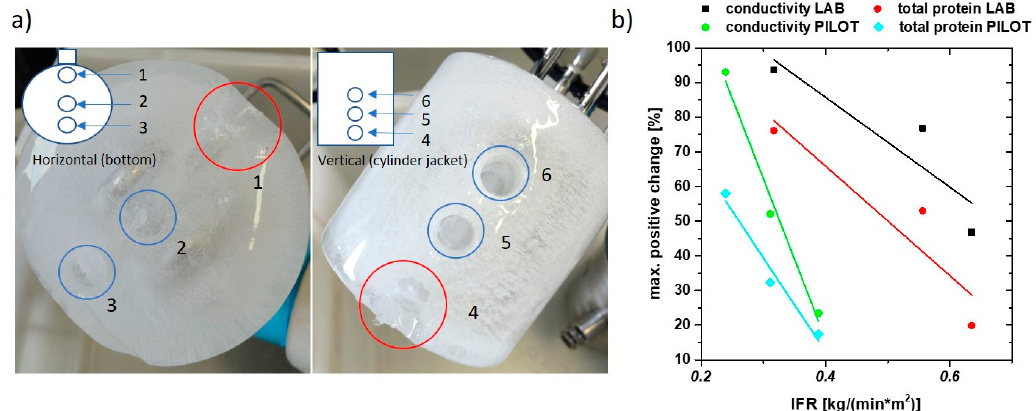
Figure 7. ( a ) Sampling scheme for tests with the pilot-scale system. Three samples were taken at the bottom of the frozen sample (horizontal) and three samples next to the jacket in different height (vertical); ( b ) conductivity and total protein concentration change in % vs. IFR. Very similar dependence for small scale and pilot scale is found.